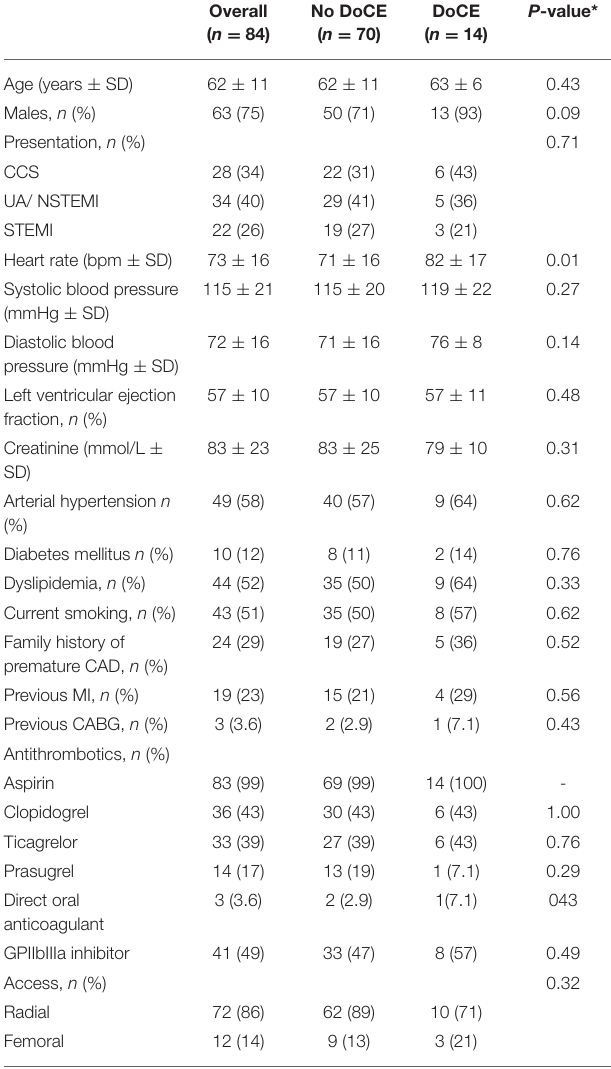
TABLE 1 | Baseline characteristics grouped according to outcomes during